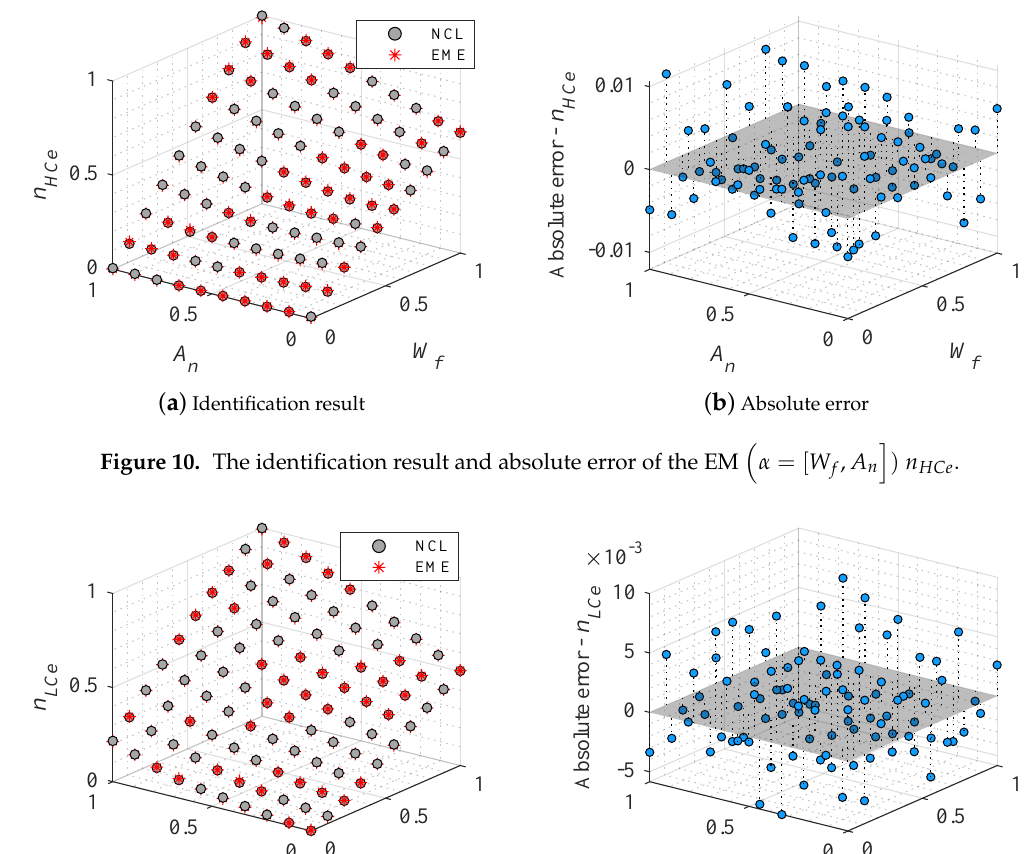
(cid:16) (cid:105) ) n α = [ W f , A n HLe .